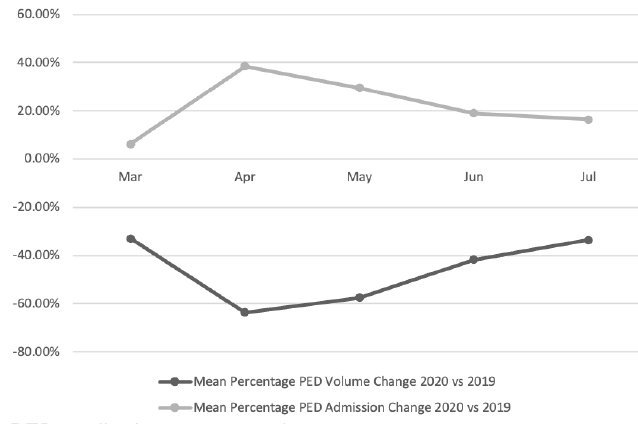
Figure 1. Mean pediatric emergency department volume and admission percentage changes over